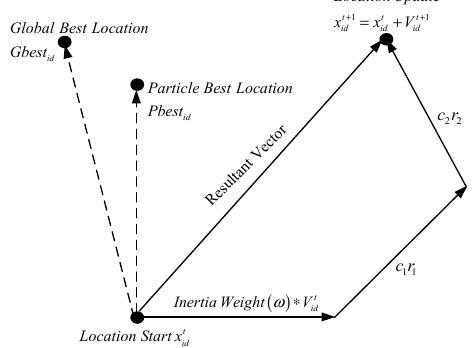
Figure 1. Particle swarm optimization (PSO) vector diagram.